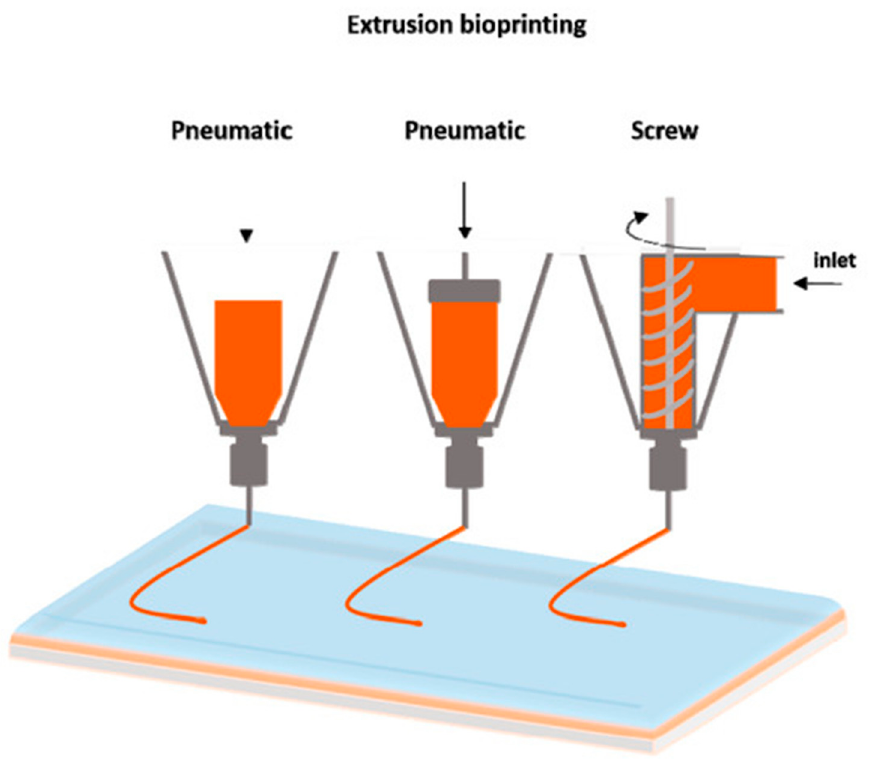
Figure 1. The main forms of extrusion printing [10]. This figure is being reprinted under a Creative Commons BY 4.0 license.